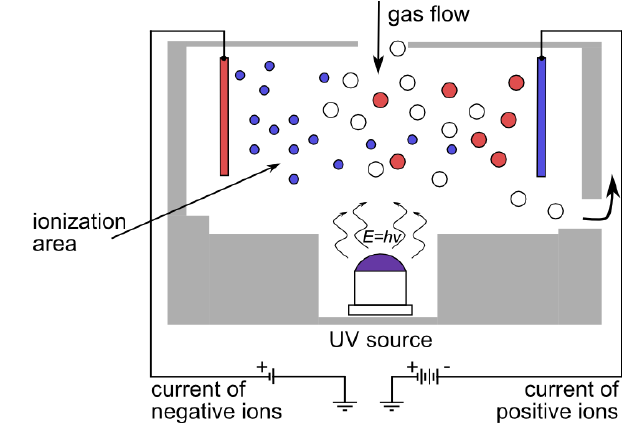
Figure 1. Basic principle of a conventional photoionization detec- tor